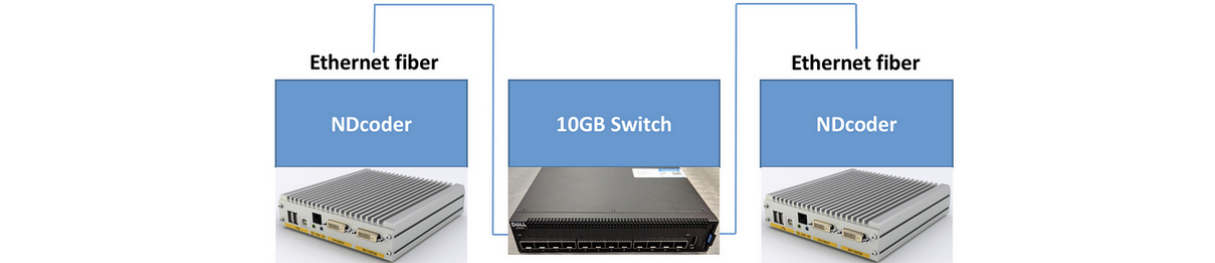
Figure 1. The basic structure of the intelligent operating room system.